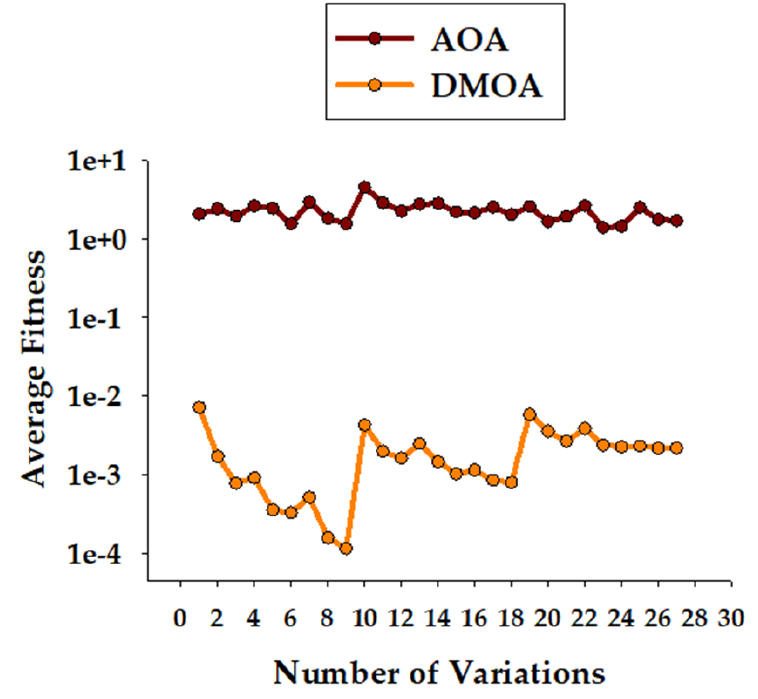
Figure 9. Kruskal–Wallis test between the DMOA and AOA, where p < 0.01.